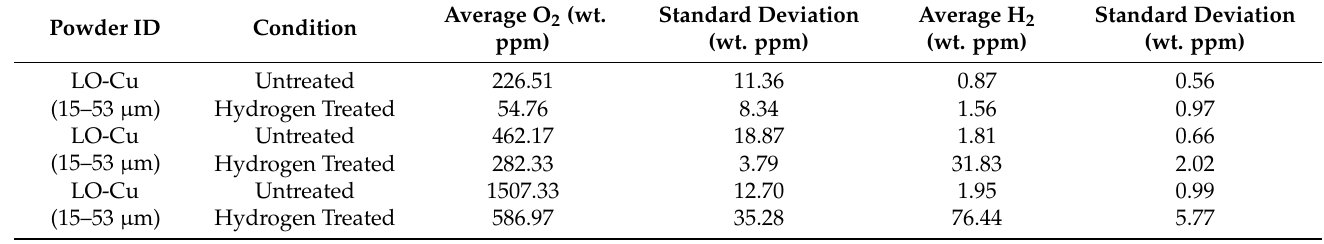
Table 2. Chemical content of copper powders. Adapted from [6] MDPI, 2019.